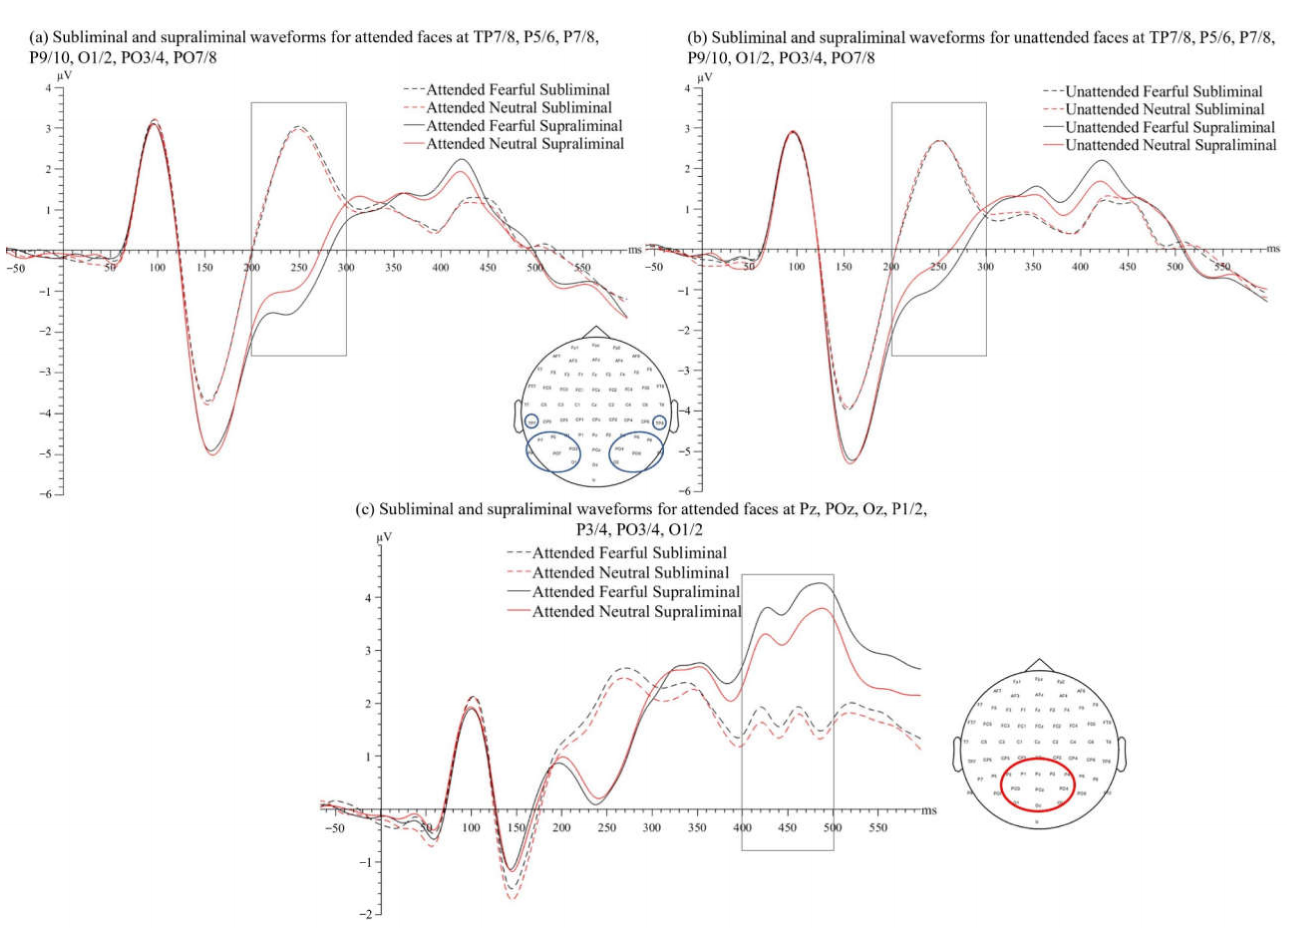
Figure 4. ERP waveforms for ( a ) attended and ( b ) unattended faces in subliminal and supraliminal viewing conditions, separated by the emotional expression (fearful and neutral), pooled from left (TP7, P5, P7, P9, O1, PO3, PO7) and right electrodes (TP8, P6, P8, P10, O2, PO4, PO8) for the VAN (time window: 200–300 ms). ( c ) ERP waveforms for attended fearful and neutral faces, averaged across the emotion of the unattended faces in subliminal and supraliminal viewing conditions, pooled from Pz, POz, Oz, P1/2, P3/4, PO3/4, O1/2 for the P3 (time window: 400–500